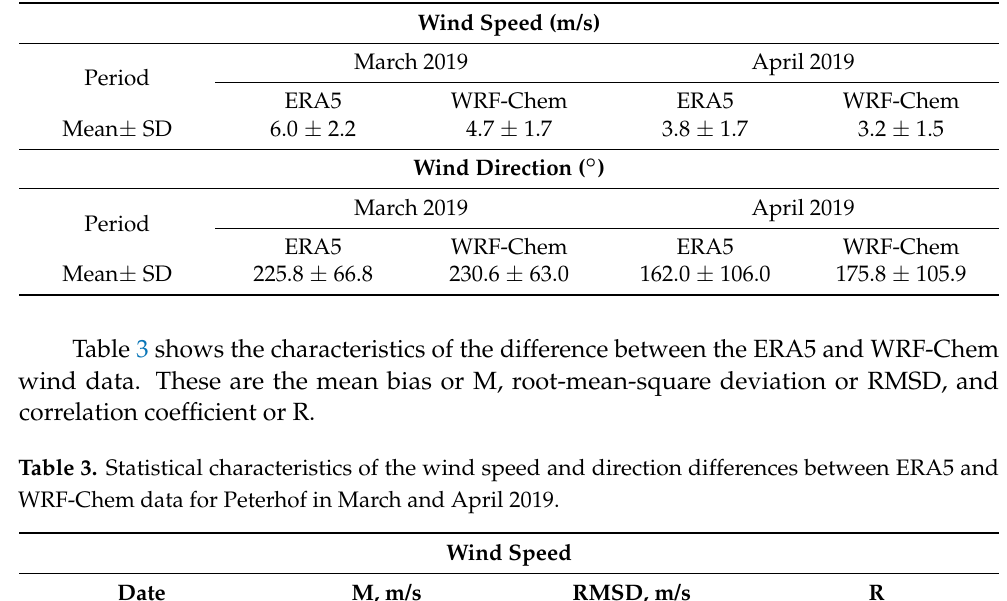
Figure 6. Temporal variation in wind direction at 10 m and differences according to the ERA5 and WRF-Chem data in March ( left ) and April ( right ) 2019 in the territory of Peterhof (Saint Petersburg). Table 2. Statistical characteristics of the wind speed and direction at 10 m according to the ERA5 and WRF-Chem data for Peterhof in March and April 2019.